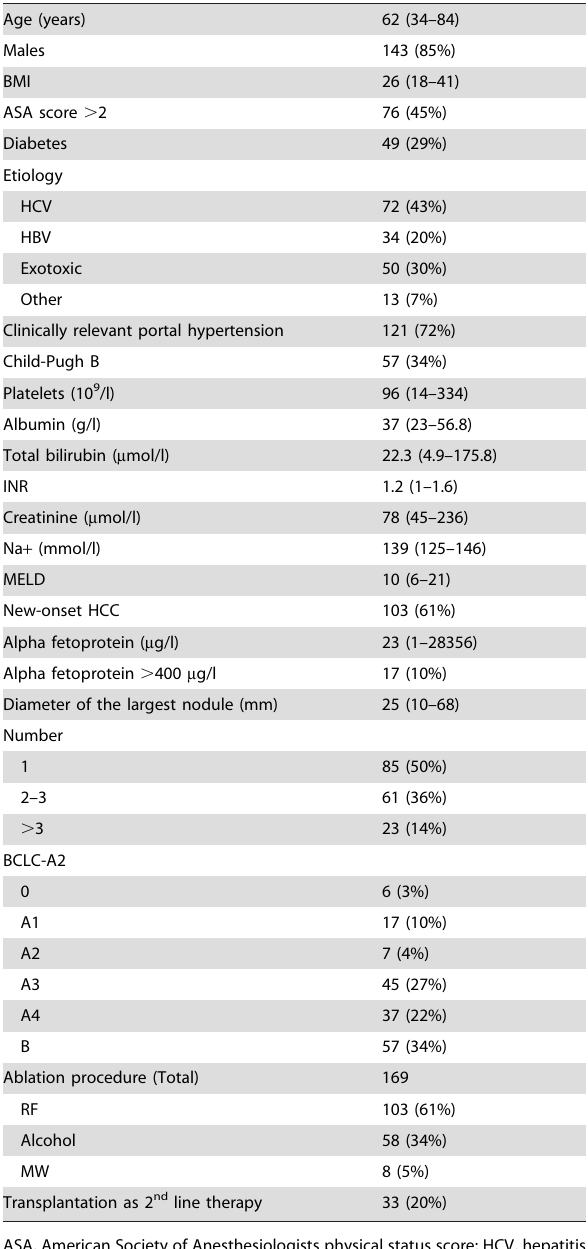
Table 2. Clinicopathological characteristics.